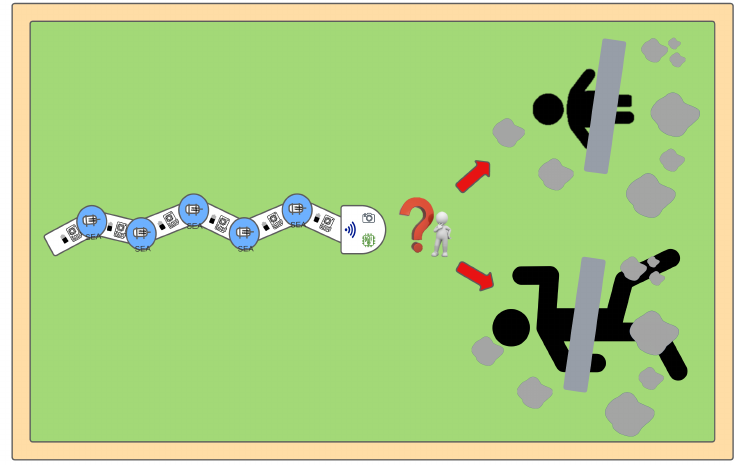
Figure 6. Ethical dilemmas in decision-making (control) in SAR